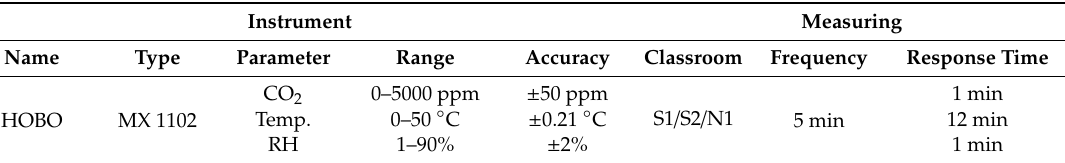
Table 2. Instrumentation technical